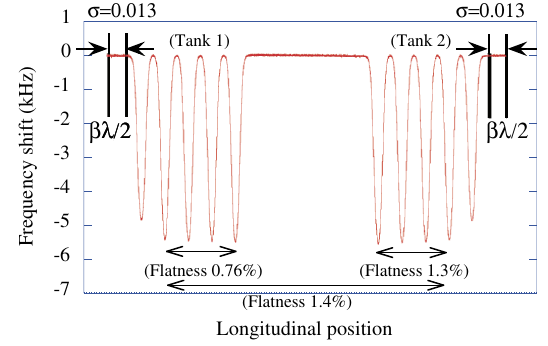
FIG. 8. Frequency shift measured with the bead-pull method. The flatness is also shown. The total flatness for the two tanks is 1.4%.